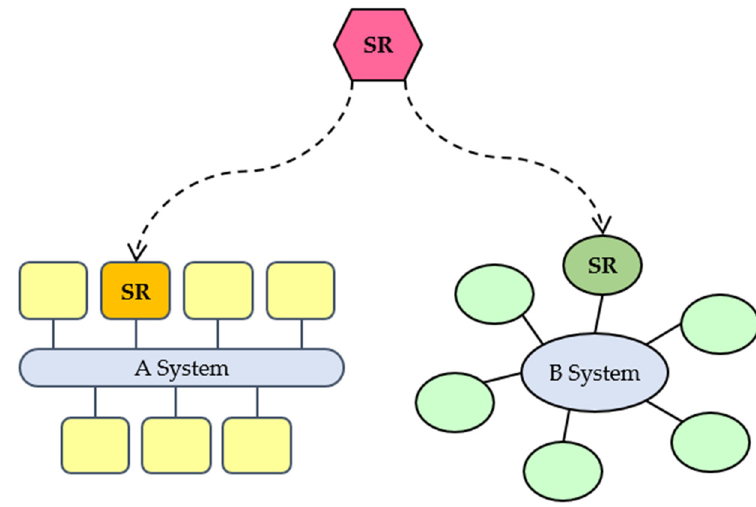
Figure 3. Concept of component reuse via interoperability.